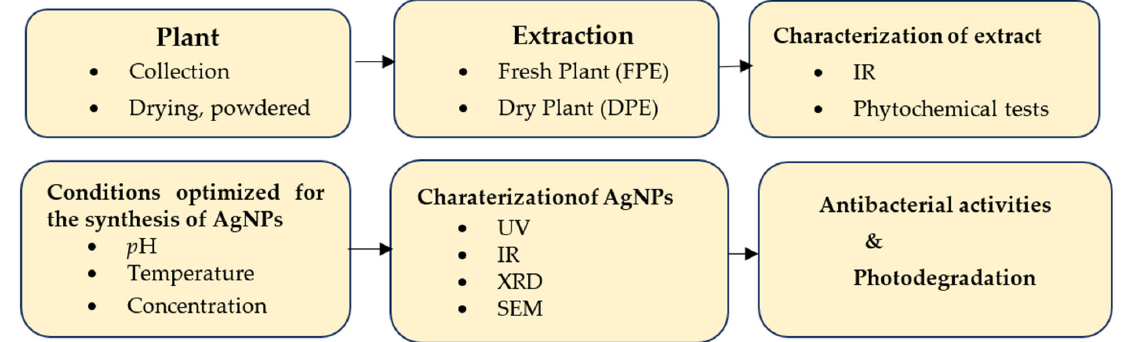
Table 1. Detection of different classes of natural products in Teucrium stocksianum . No.